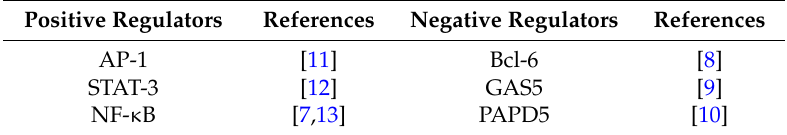
Table 1. List of well-known positive and negative regulators of miR-21